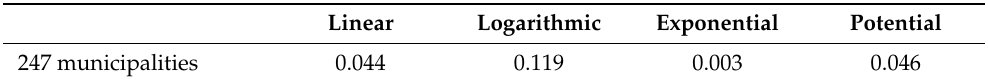
Table 6. R 2 value upon correlating MRW and the tertiary roadway length between villages and districts with their municipal capital (247 municipalities). Linear Logarithmic Exponential Potential